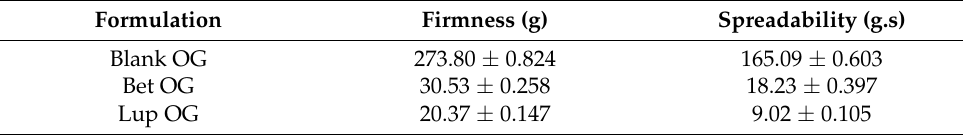
Table 3. Textural parameters (firmness and spreadability) of studied oleogels.